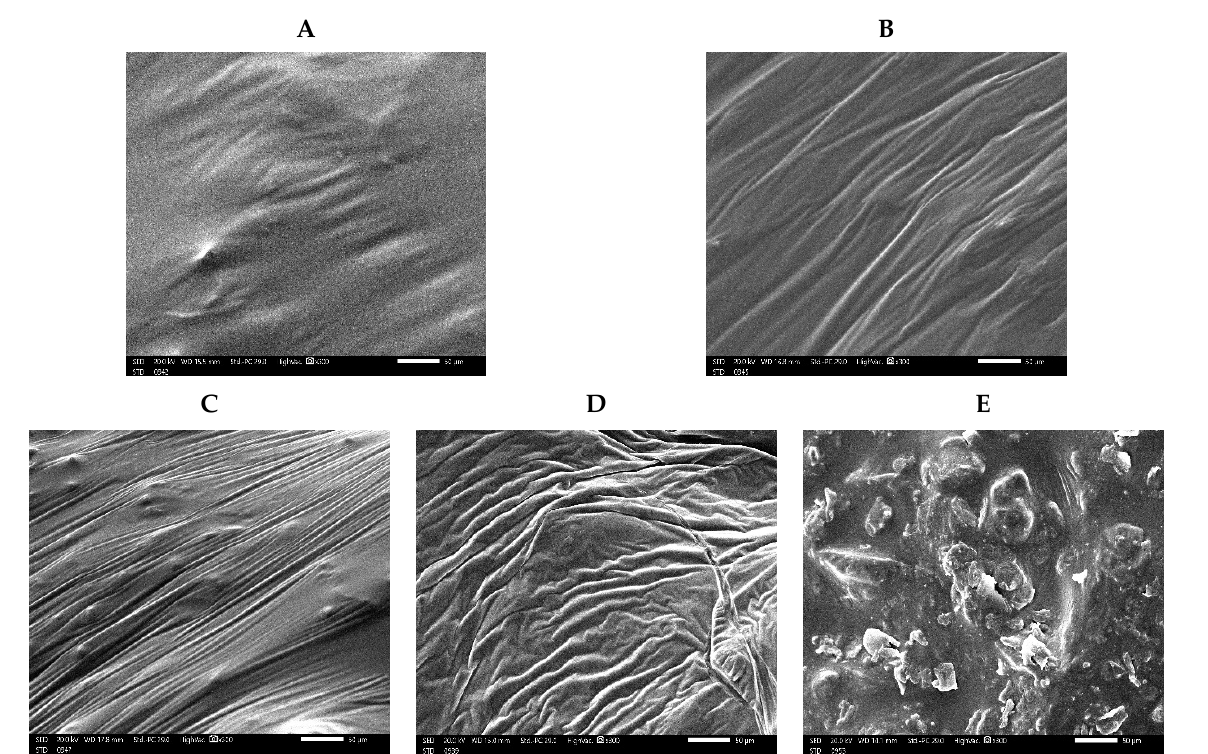
Figure 3. Scanning electron micrographs of date jam prepared with different amounts of powdered date press cake ( A : 0% DPC; B : 3% DPC; C : 6% DPC; D : 9% DPC; E : 12% DPC).